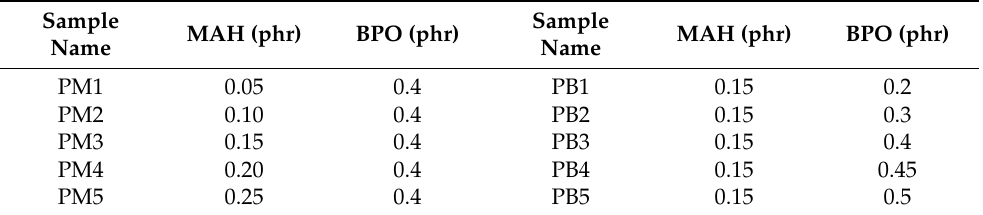
Table 1. Experimental design by varying Maleic Anhydride (MAH) at constant Benzoyl Peroxide (BPO), and varying BPO at constant MAH.